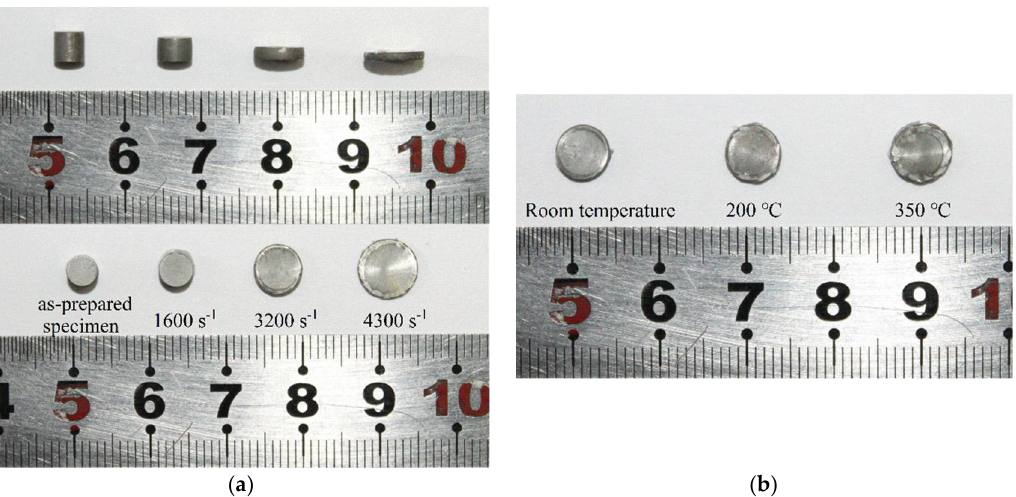
Figure 8. Morphology of the specimens after tests. ( a ) Tests at room temperature; ( b ) tests at the strain rate of 3200 s −1 .